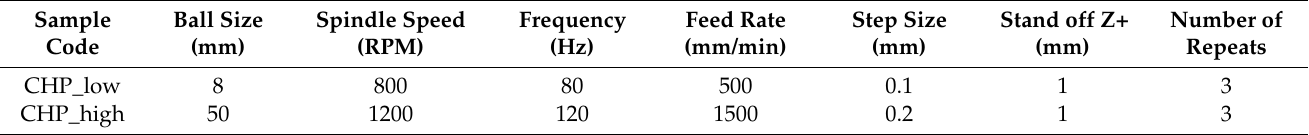
Table 3. Processing conditions used for controlled hammer peening (CHP).